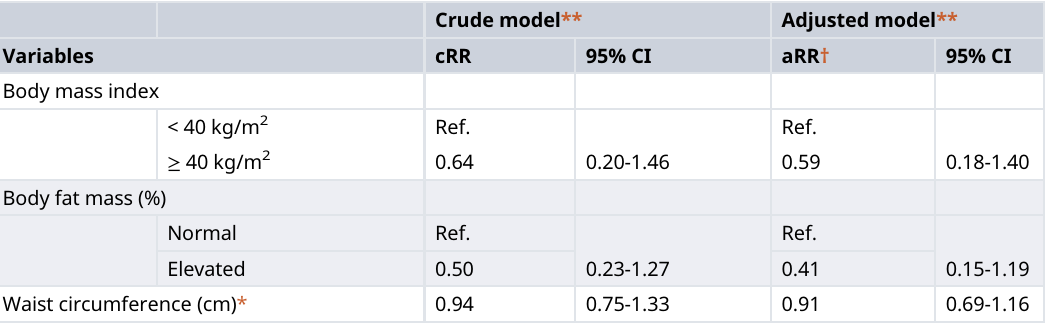
Table 4. Association between the body mass index, waist circumference, body fat mass and the development of